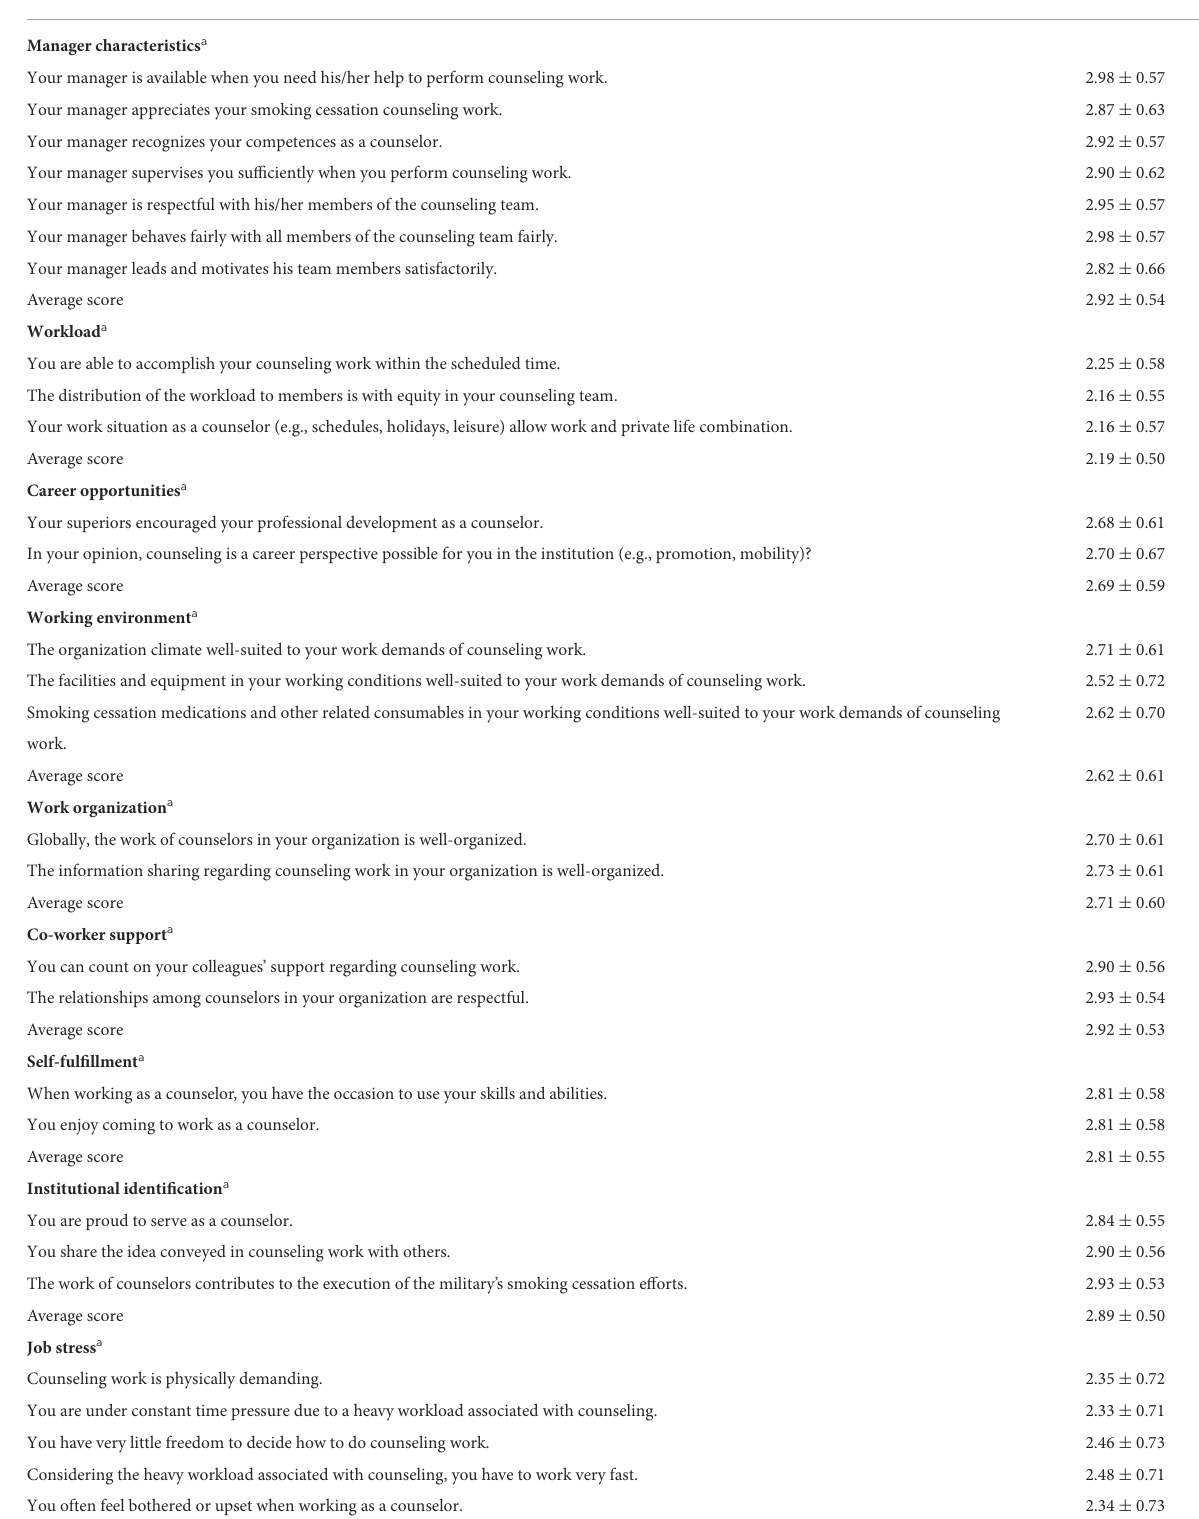
TABLE 3 Descriptive statistics for the effect of CMIS-based questionnaire items on intention to